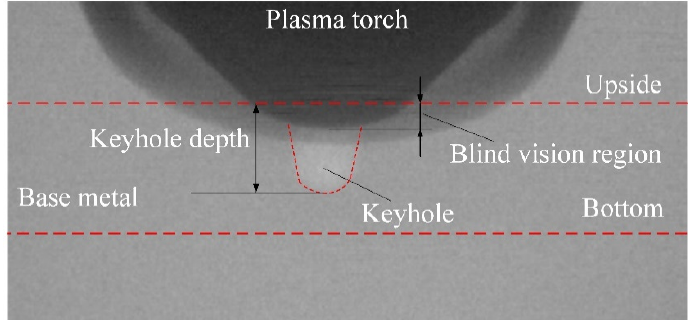
Figure 4. Diagram of the observation results of the small hole boundary.